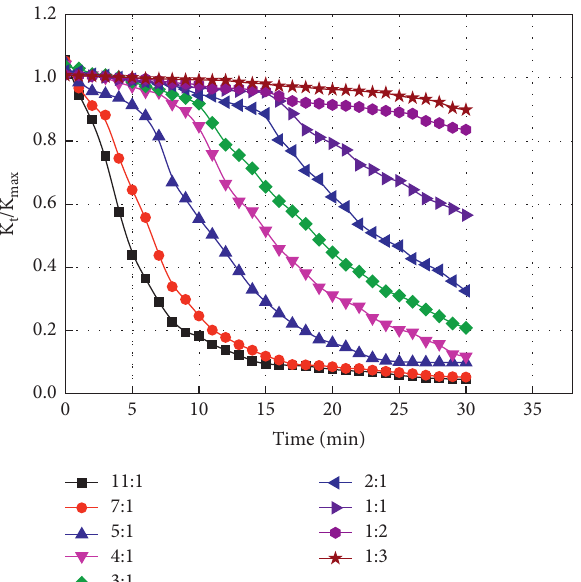
Figure 4: The curve of foam relative conductivity changing with time under different surfactant mass ratios. Table 4: The fitting linear equations of foam relative conductivity with time under different mass ratios. Mass ratio of APG and SCA Fitting linear equations Fitting